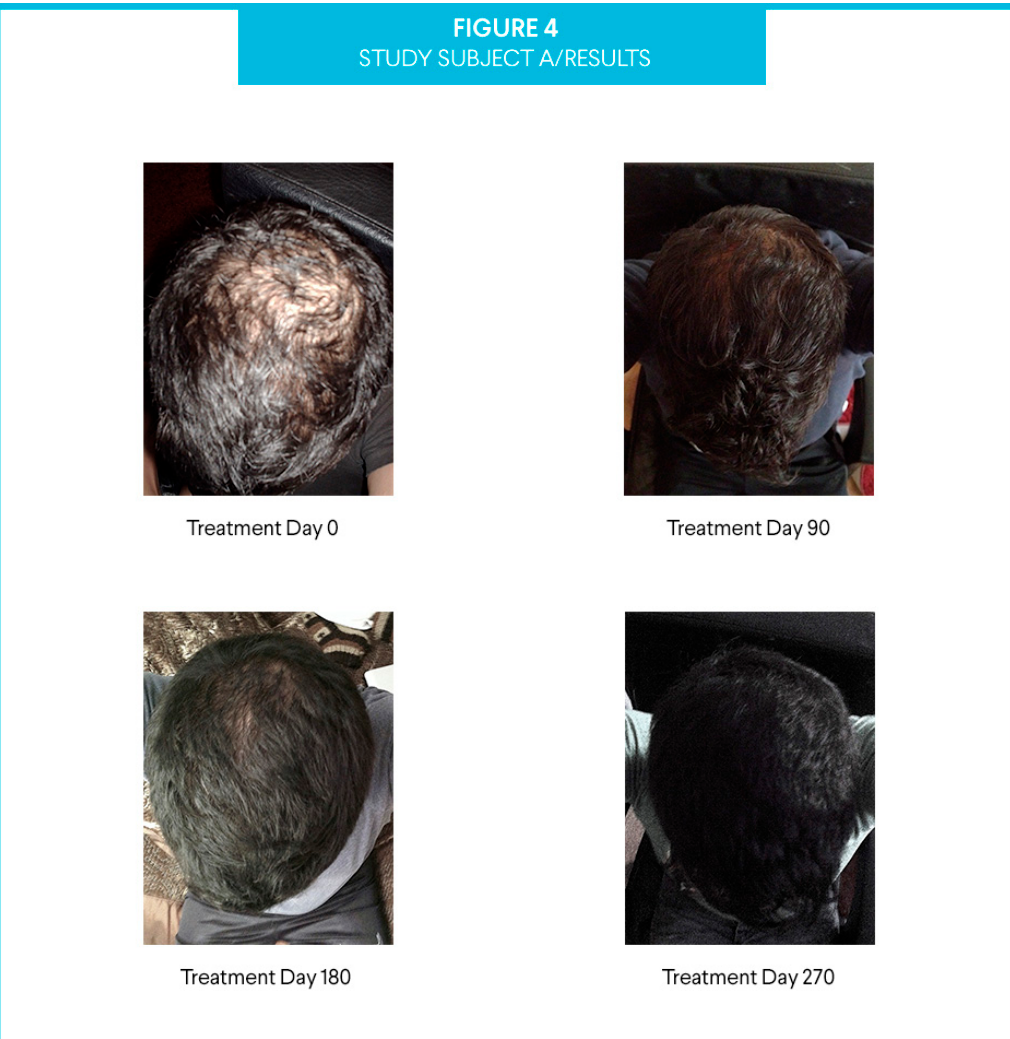
Figure 4. Subject A / hair caliber / 90-day time intervals.